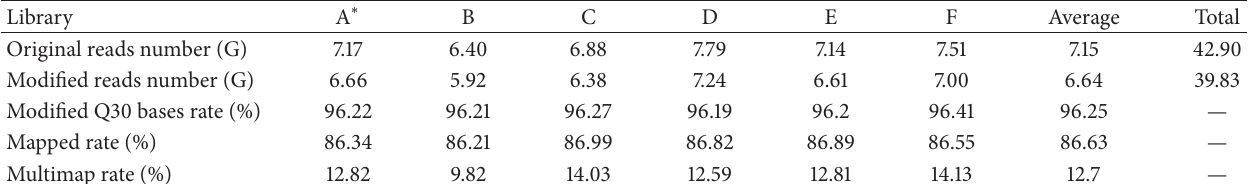
Table 1: RNA-sequencing data filtering analysis.